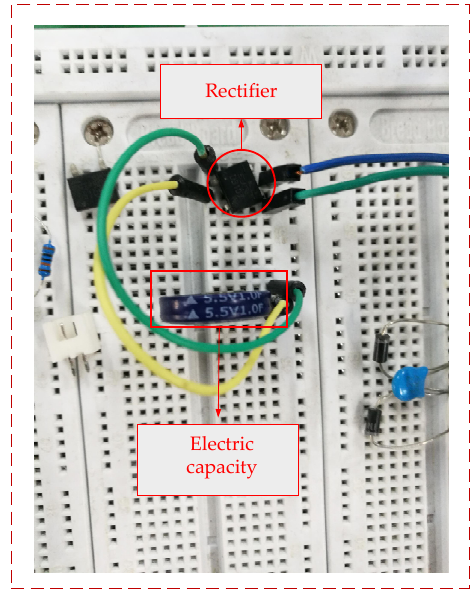
Figure 23. Circuit connection on breadboard.